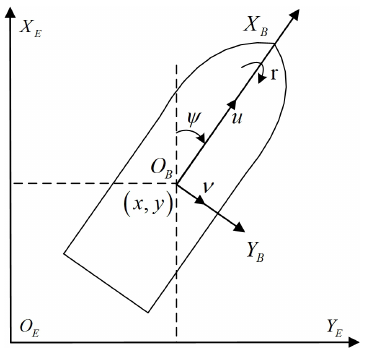
Figure 1. Earth-fixed frame and body-fixed